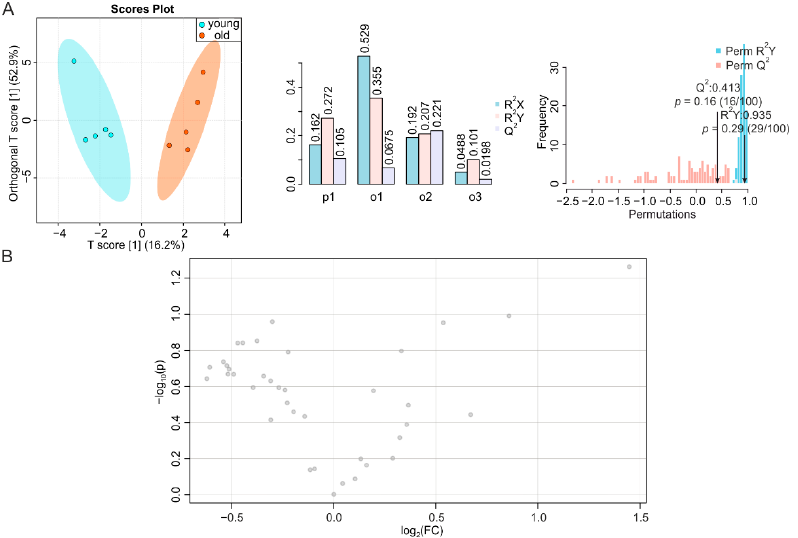
. . Figure 6. NMR-based metabolomics analysis of jejunum. ( A ) O-PLS-DA plot and cross validation of jejunum samples from young (blue) and old (orange) mice (left), with n = 5 each, and permutation between predictive component (p1) and three orthogonal components (o1, o2, o3) with cross-validated R 2 X, R 2 Y, and Q 2 coefficients (middle), and histogram showing permutation test with permutation number n = 100 (right). ( B ) Volcano plot of differentially regulated metabolites in the jejuna of young and aged mice. Grey dots denote insignificantly changed